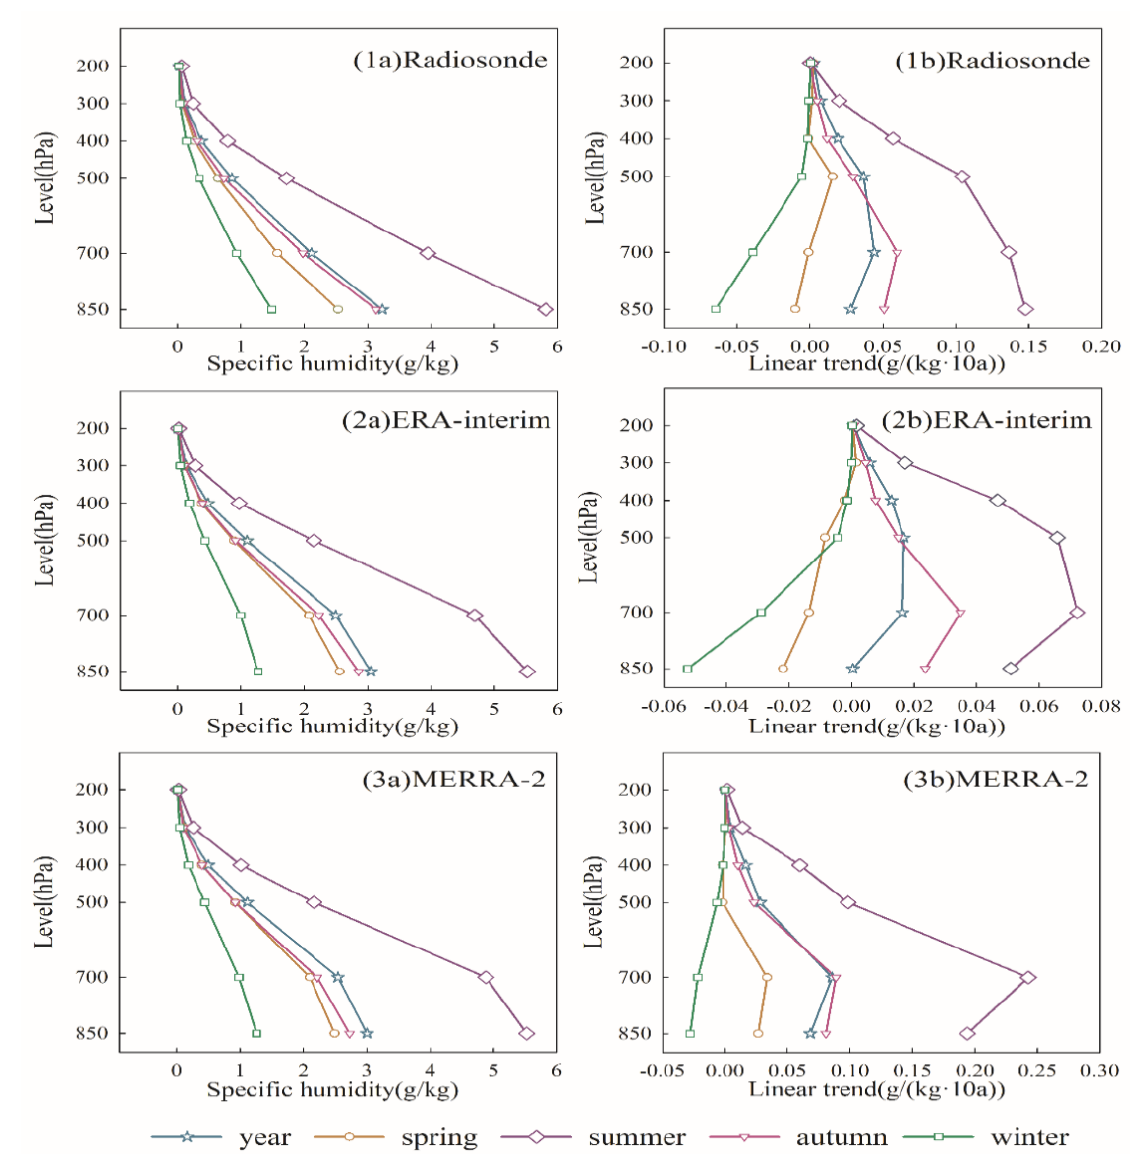
Figure 5. Vertical profiles of annual and seasonal specific humidity ( 1a , 2a , 3a ) and linear trends ( 1b , 2b , 3b ) of area average during the period 1980–2018.